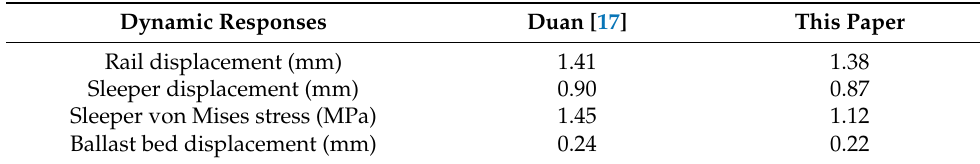
Table 4. The maximum dynamic